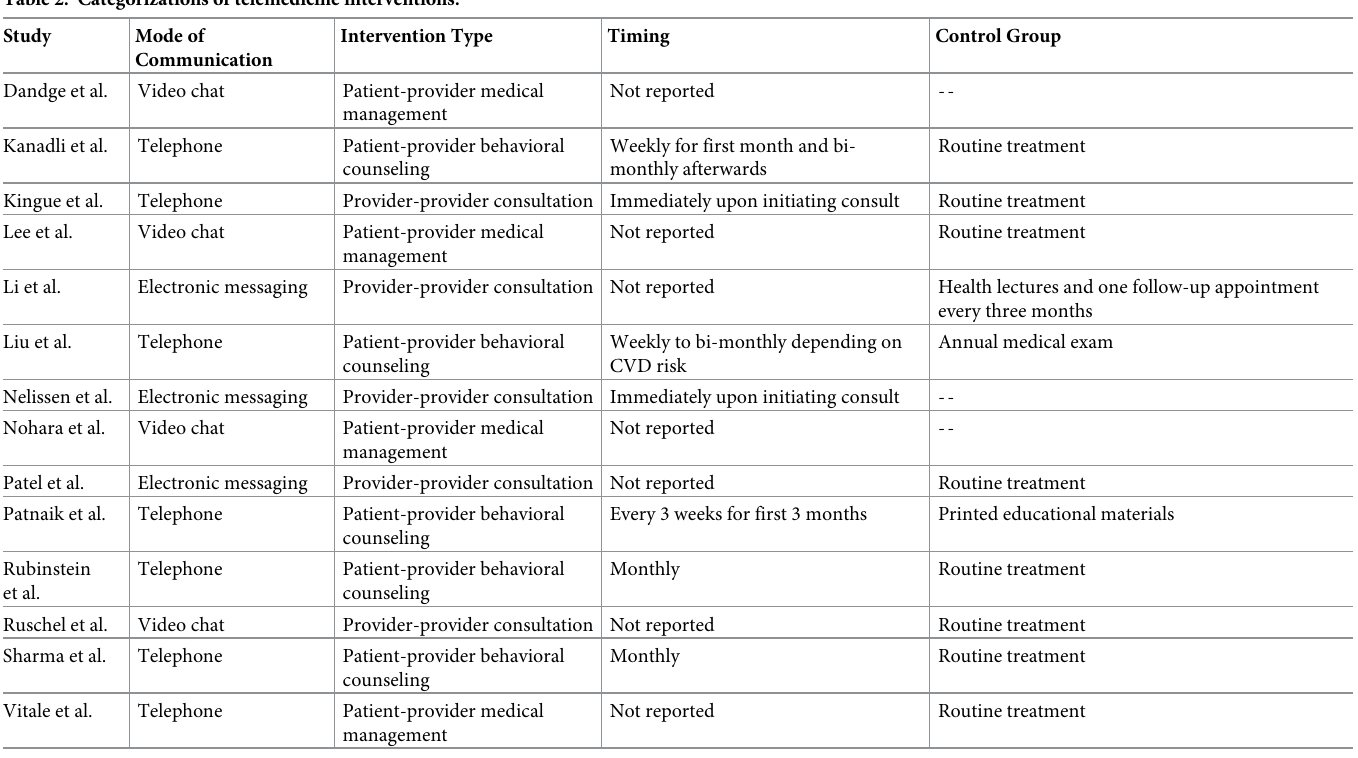
Table 2. Categorizations of telemedicine